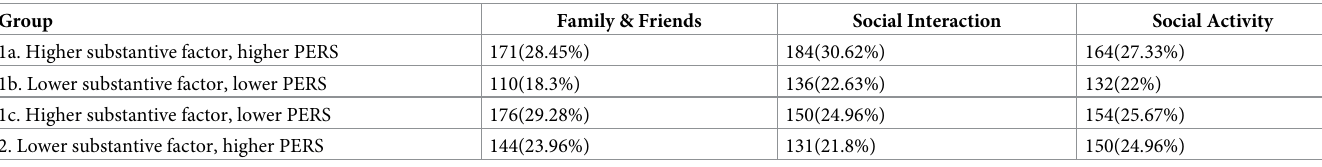
Table 2. Subjects grouped by substantive factor and